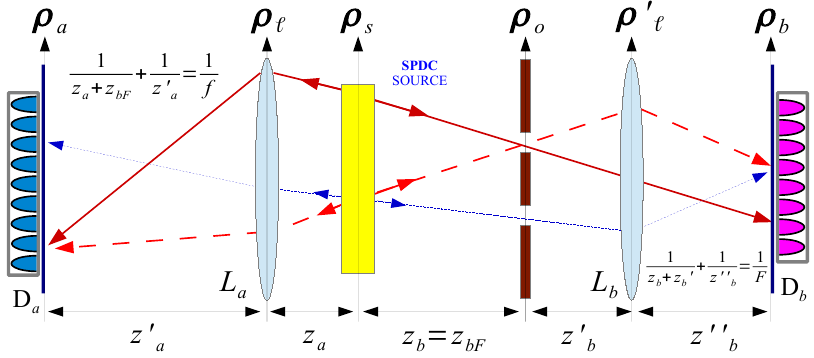
Figure 13. The unfolded version (Klyshko picture) of the setup represented in Figure 12 shows the combined focusing effect on the basis of CPI with entangled photons: on one hand, the lens L a focuses the ghost image of the object (by correlation measurement) on the detector D a ; on the other hand, the lens L b reproduces on D b the image of the source, filtered by the object transmission function. Adapted with the permission from [41], copyright MDPI, 2016. The solid and dashed lines represent two-photon amplitudes transmitted by the same object point, and eventually focused on the same pixel of D a . The dashed and dotted lines are emitted by the same source point and focused in the same pixel of D b